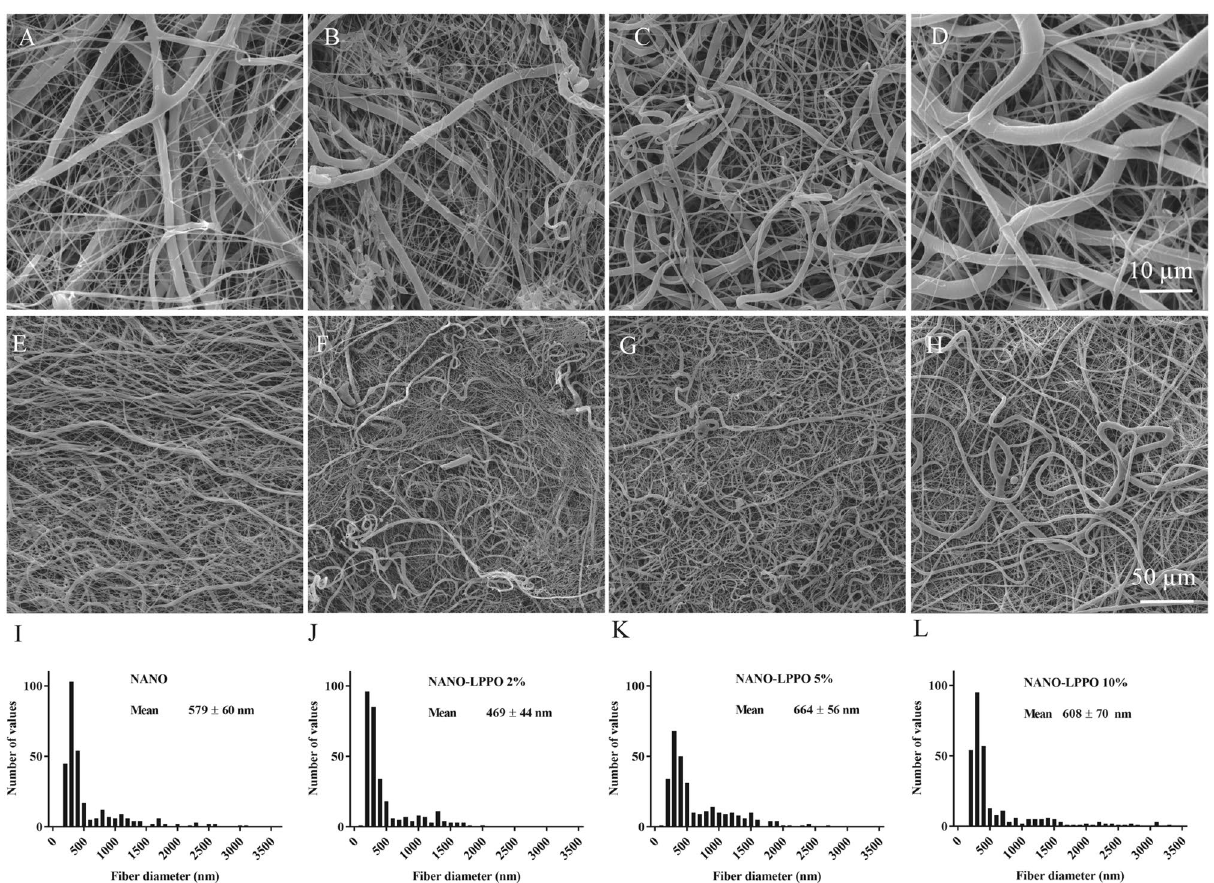
Figure 1. Representative photomicrographs from scanning electron microscope ( A – H ) and corresponding fiber diameter analysis (histograms, mean ± 95% confidence interval, n = 300) of electrospun PCL material ( I – L ) containing different amount of LPPO: 0% ( A , E , I ), 2% ( B , F , J ), 5% ( C , G , K ) and 10% ( D , H , L ). Scale bar top panel—10 µm (magnification 5000×), bottom panel—50 µm (magnification